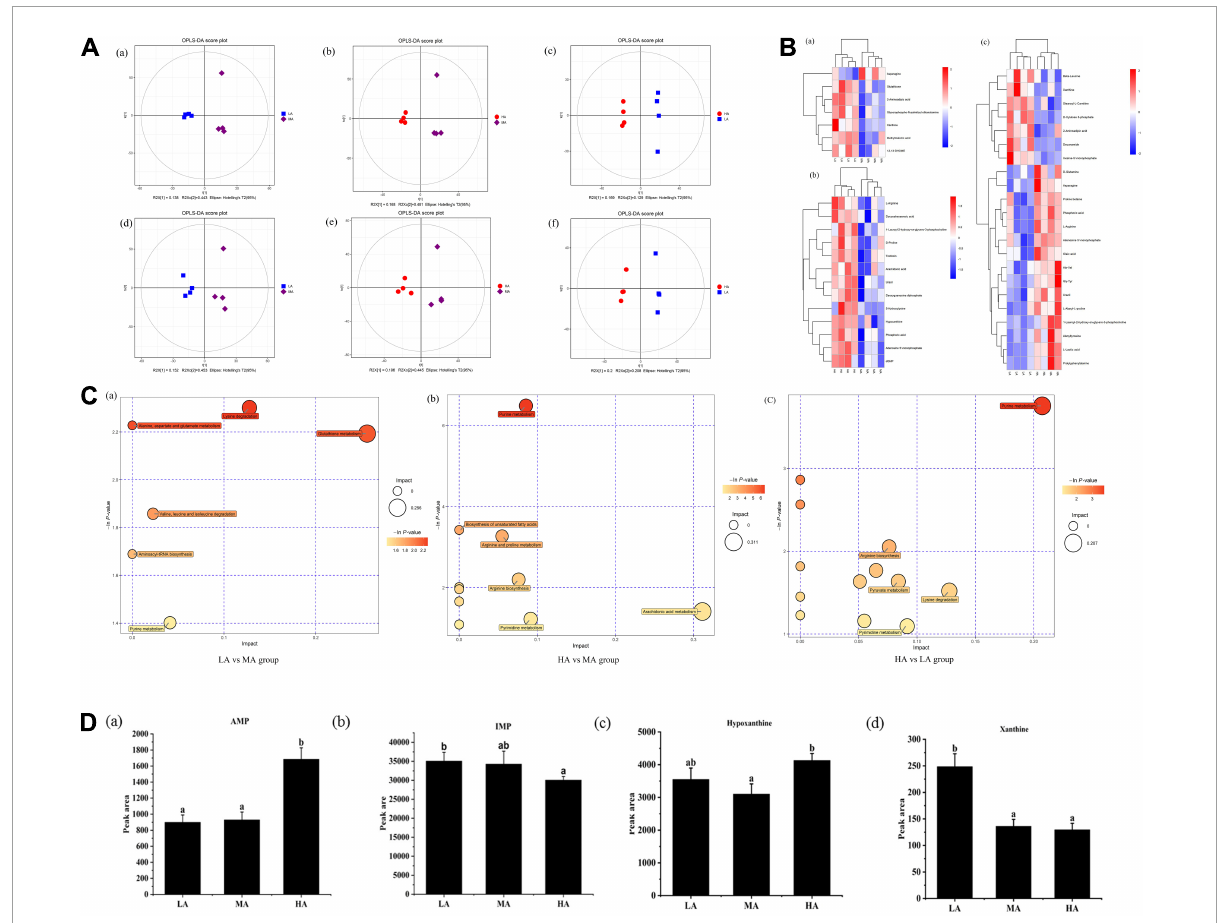
FIGURE2 Untargeted metabolomics profiling of muscle in L. vannamei after dietary arginine treatment for 56 days. (A) OPLS-DA score plot of different comparison groups in ESI+ (a–c) and ESI– (d–f) model. (B) Heatmap of differential metabolites in different comparative groups. (a) Between LA and MA groups; (b) between HA and MA groups; (c) between LA and HA groups. (C) Metabolome view map of relevant metabolic pathways for change (a) between LA and MA groups; (b) between HA and MA groups; (c) between HA and LA groups. (D) Peak areas ( × 106) of four flavoring substances involved in purine metabolism were detected based on muscle non-targeted metabolomics. (a) AMP; (b) IMP; (c) hypoxanthine; (d) xanthine. LA, the arginine-deficient diet; MA, the arginine-optimal diet; HA, the arginine-excessive